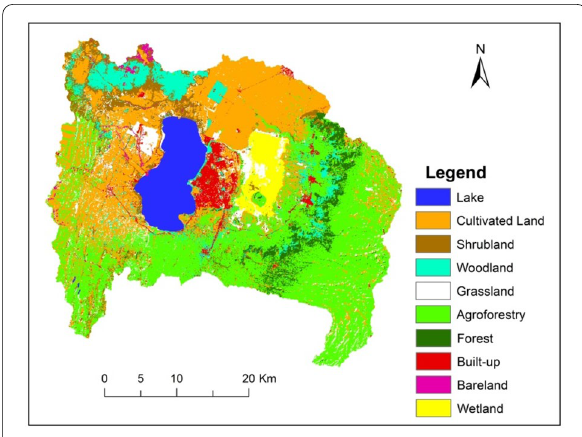
Fig. 2 LULC map of Lake Hawassa